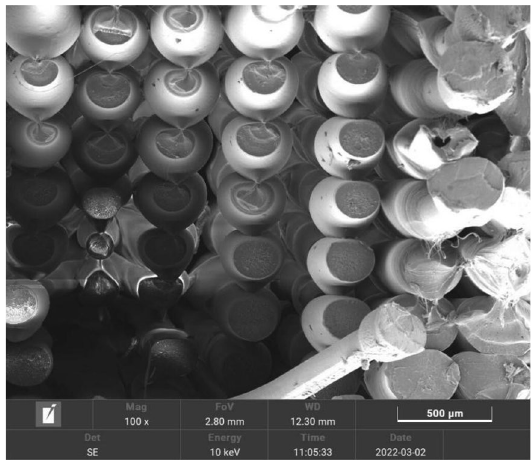
Figure 9 SEM micrograph of tensile fractured specimen obtained from confirmation experiment